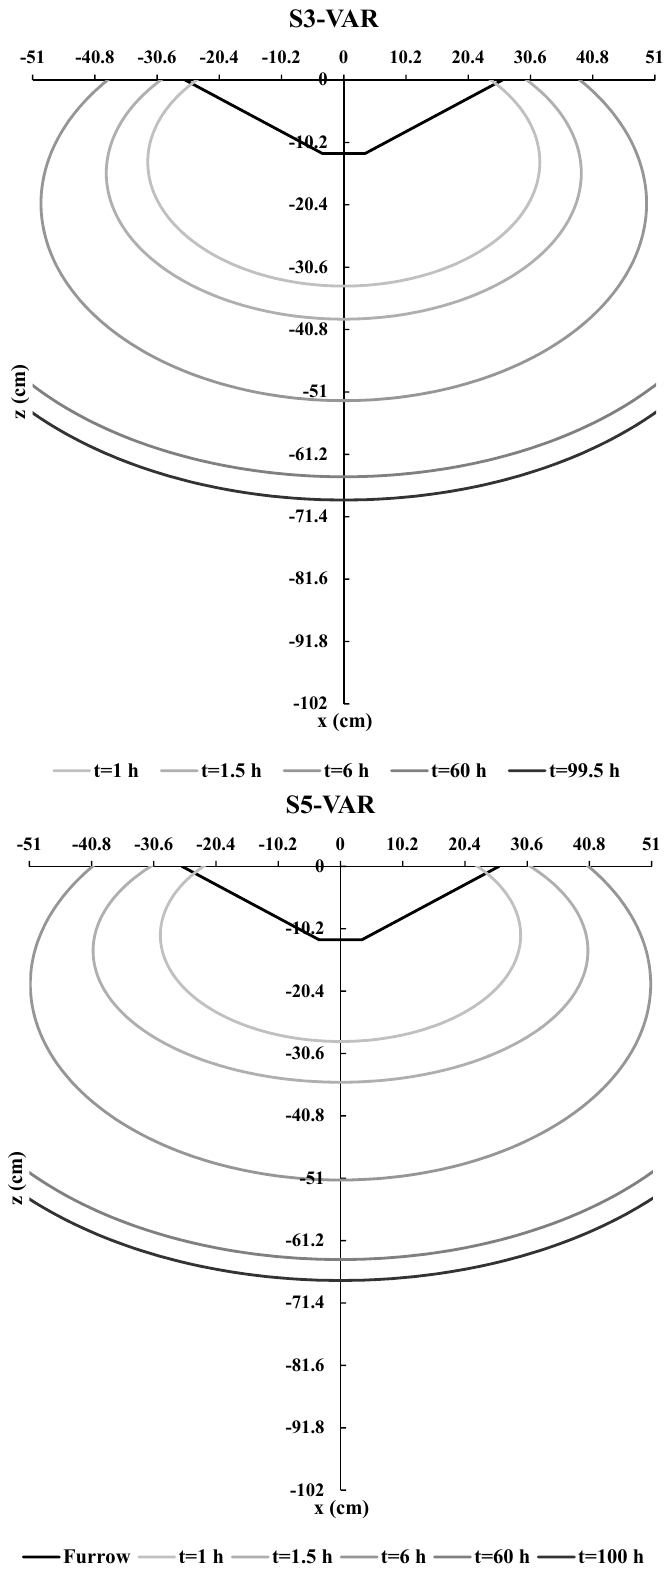
Figure 5. The time-evolving ellipses with variable (VAR) head calculations at stations 1 (S1), 3 (S3), and 5 (S5). Table 6. The location of the center of mass, 𝑧 (cid:3004) , and the semi axes of the ellipses, 𝜎 (cid:3051) and 𝜎 (cid:3053) , with variable (VAR) ponding depth at stations 1 (S1), 3 (S3), and 5 (S5). S1-VAR S3-VAR S5-VAR Time